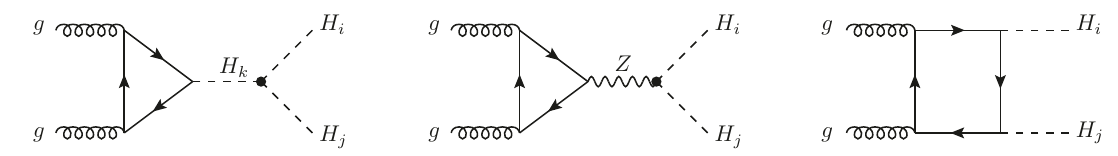
Figure 1 . Generic diagrams contributing to leading-order C2HDM Higgs H i H j ( i, j, k = 1 , 2 , 3 ) pair production in gluon